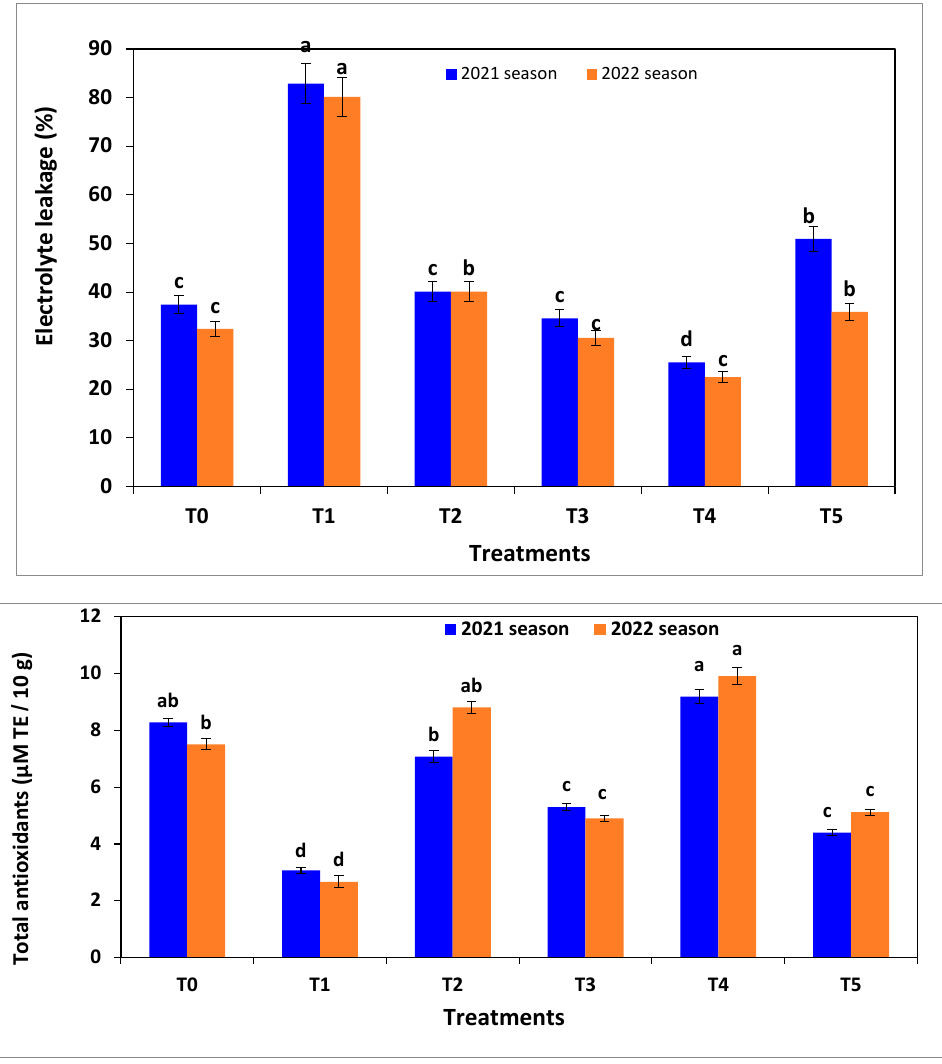
Figure 8. Effects of different treatments on the antioxidative capacity and electrolyte leakage, which were measured after 30 days from applying treatments. For more details about treatments, refer to Table 1. Values of means in each column followed by the same letter are not significant at p < 0.05.